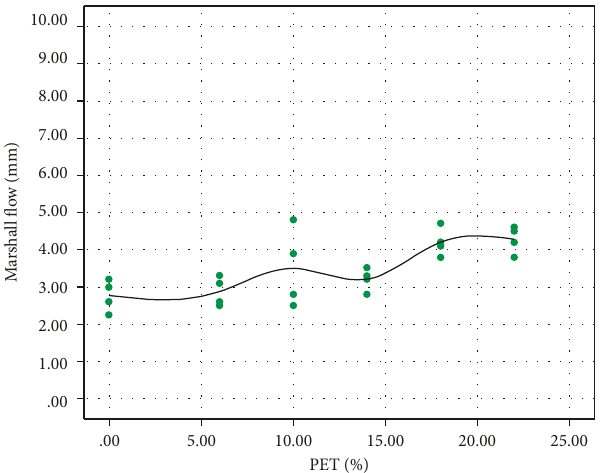
Figure 5: Marshall flow for different percentages of